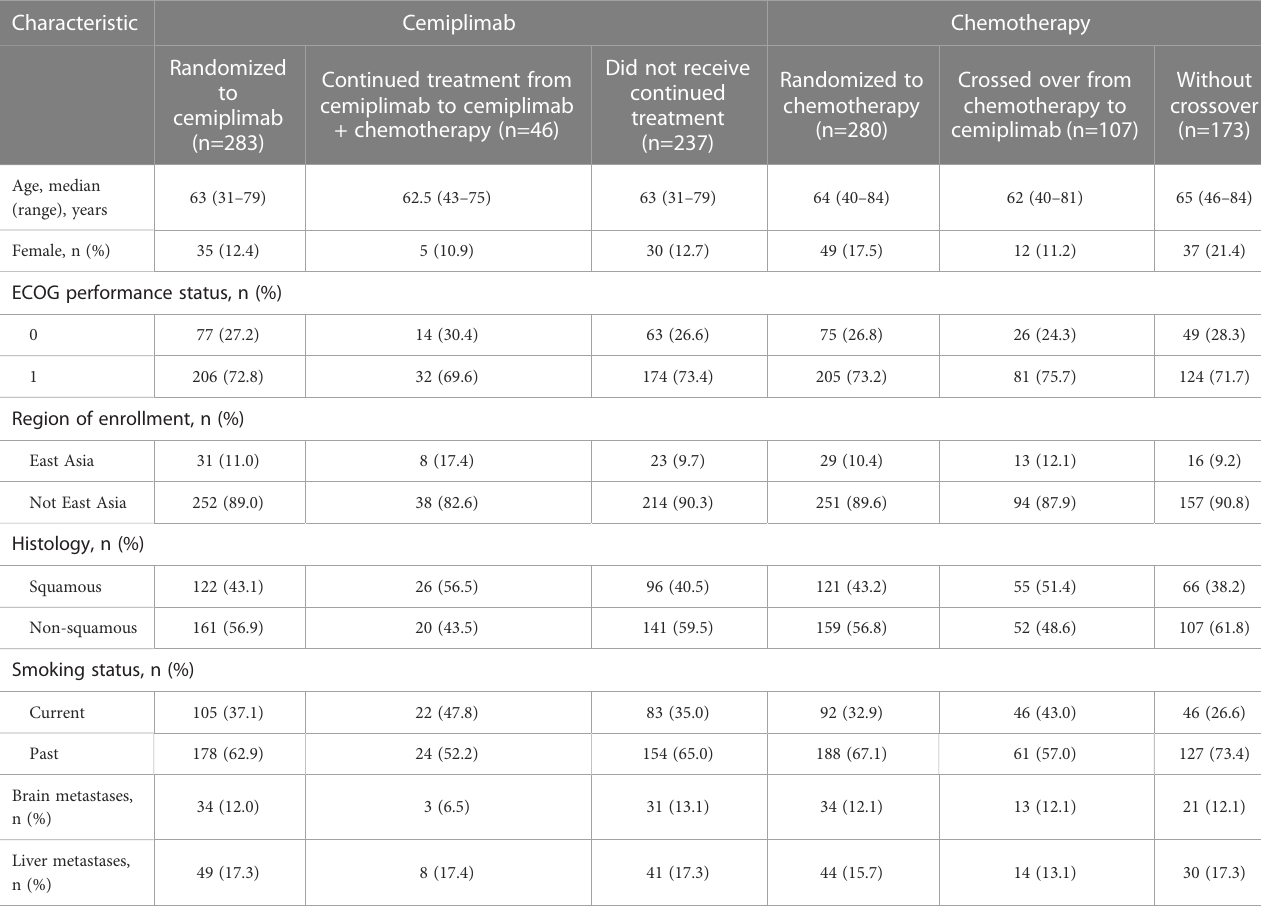
TABLE 1 Demographic and baseline disease characteristics among the EMPOWER-Lung 1 PD-L1 ≥ 50% population. Characteristic